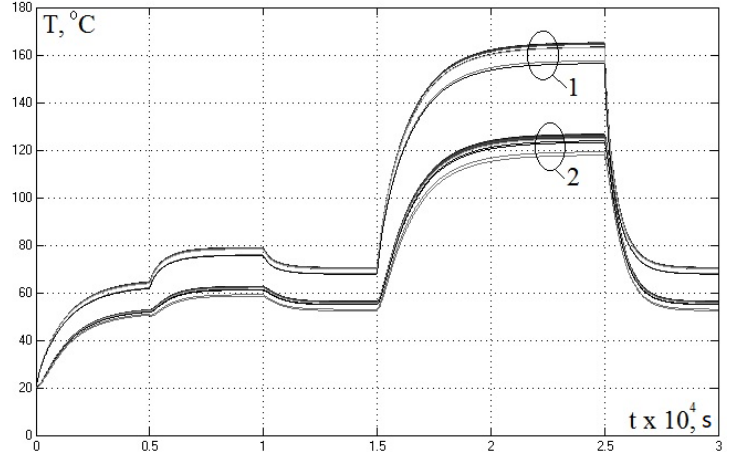
Figure 10. Average temperatures along primary length. Curve group 1—primary winding on tooth pitches; curve group 2—magnetic core on tooth pitches.